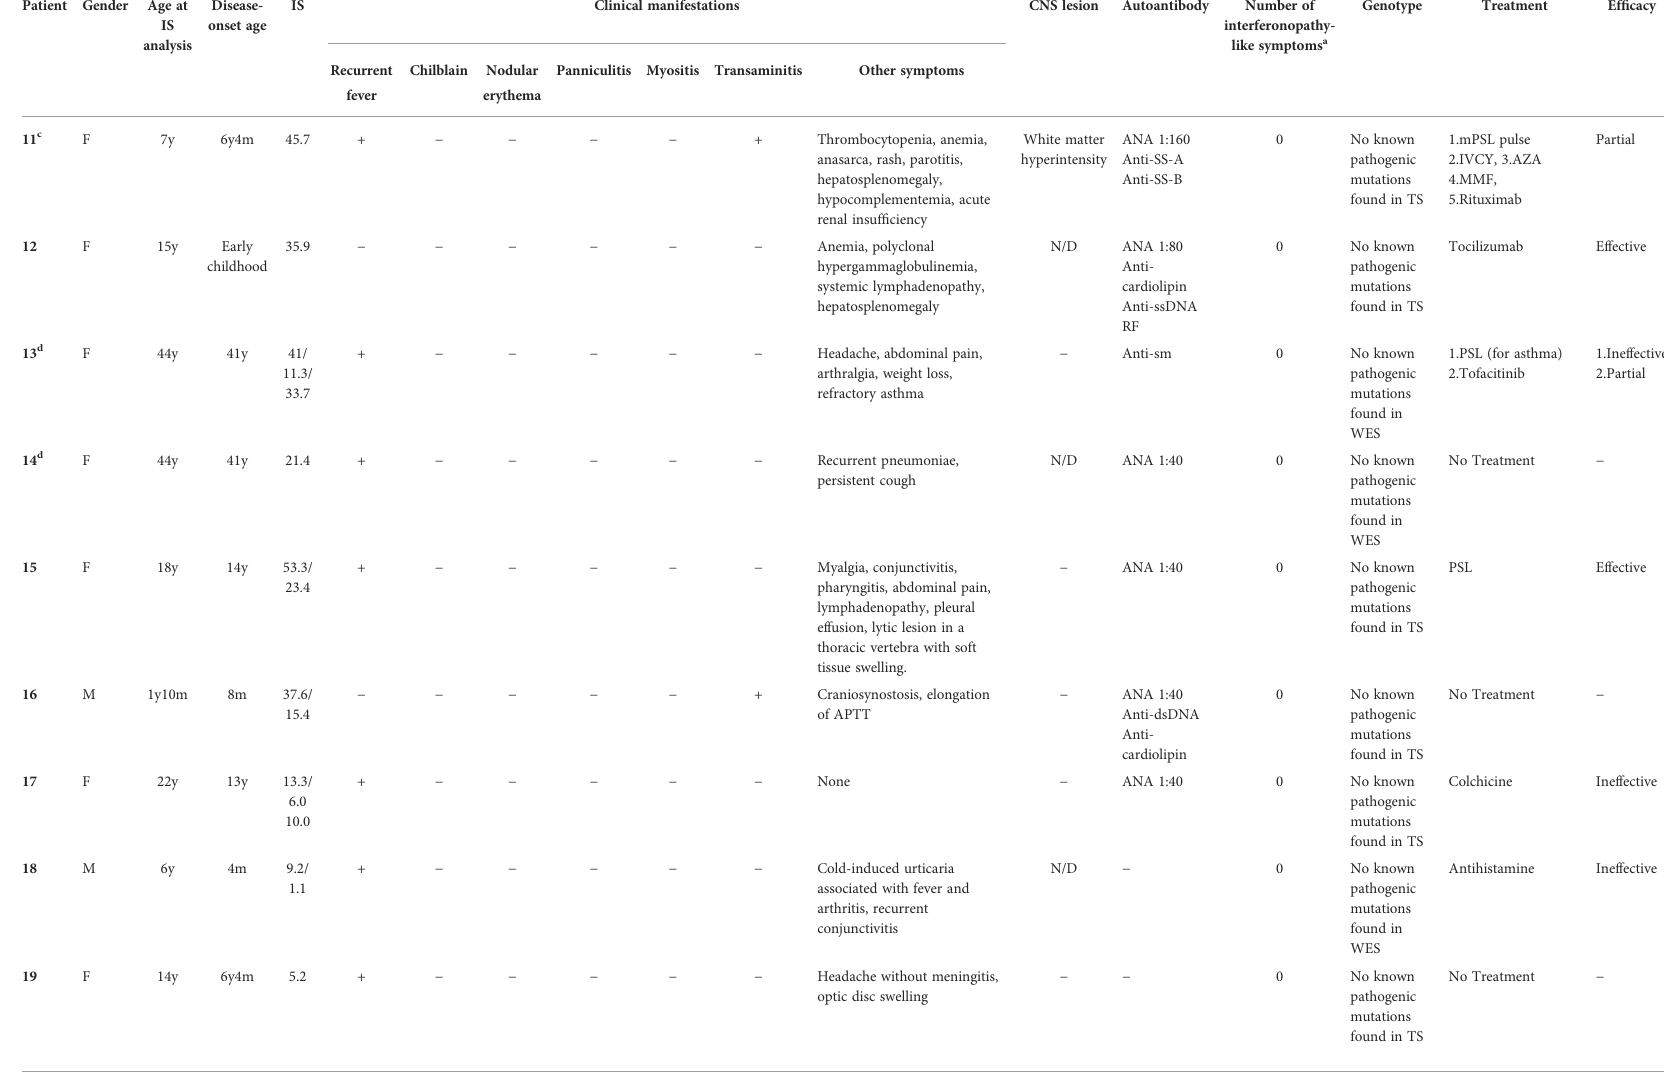
a: Interferonopathy-like symptoms include nodular erythema, chilblain-like erythema, panniculitis, myositis, basal ganglia calci fi cation, and interstitial pneumoniae. b: Patient 3 is the father of patient 2. c: Patient 7 and 11 have been previously studied (34, 35). d, Patient 13 is an elder sister of patient 14. M, male; F, female; TAC, tacrolimus; CyA, cyclosporine; MTX, methotrexate; AZA, azathioprine; mPSL, methylprednisolone; IVCY, intravenous cyclophosphamide; MMF, mycophenolate mofetil ; N/D, no